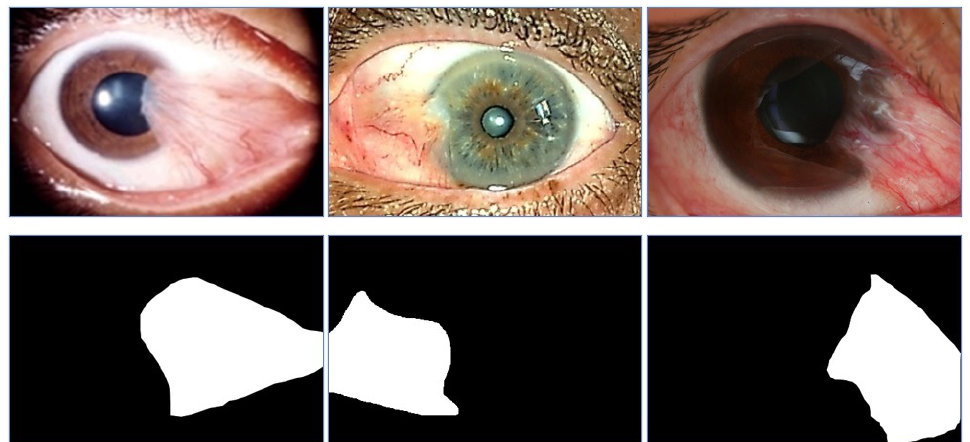
Figure 6. Samples of pterygium images and their corresponding ground truth semantic images. The first row of images are the original anterior segment photograph images and the second row of images are the corresponding ground truth label